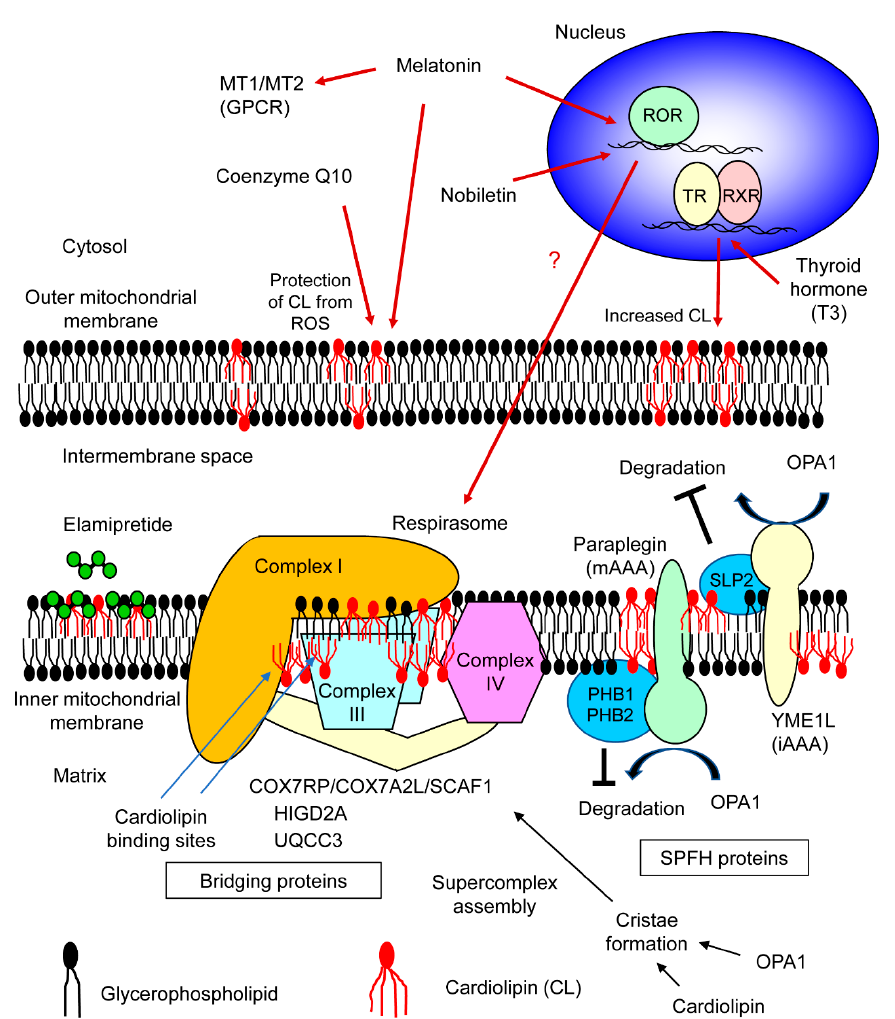
Figure 1. Molecules involved in mitochondrial respiratory chain supercomplex assembly. The respiratory chain supercomplex assembly factors and molecules affecting supercomplex formation which are reported to function in mitochondria of vertebrates are shown. Cardiolipin (CL), a phospholipid with four acyl chains, directly binds respiratory chain complexes on the cardiolipin binding sites in each complex. Cardiolipin may indirectly support mitochondrial respiratory chain supercomplex formation by maintaining cristae structure. COX7RP (cytochrome c oxidase subunit 7a-related polypeptide; also known as COX7A2L/SCAF1), HIGD2A (HIG1 hypoxia inducible domain family, member 2A), and UQCC3 (ubiquinol-cytochrome c reductase complex assembly factor 3) function as bridging proteins by direct binding with each respiratory chain complex. PHB1 (prohibitin 1), PHB2 (prohibitin 2), and SLP2 (stomatin-like protein 2) are SPFH (stomatin, prohibitin, flotillin, and Hflk/C) proteins which inhibit activity of proteases, mAAA (a member of AAA (ATPase associated with diverse cellular activities) proteins with enzymatic sites in the matrix of mitochondria) and iAAA (a member of AAA proteins with enzymatic sites in the intermembrane space of mitochondria), causing degradation of OPA1 (optic atrophy 1) responsible for the maintenance of cristae structure. Five bioactive small molecules are also shown. Coenzyme Q10 and melatonin are antioxidants that protect cardiolipin from reactive oxygen species (ROS). Functions of melatonin are also mediated by its G-protein coupled receptors (MT1 and MT2) or by nuclear receptor ROR (retinoid acid receptor-related orphan receptor). Nobiletin also activates ROR. T3 type of thyroid hormone binds to thyroid hormone receptor (TR). TR forms heterodimer with retinoid X receptor (RXR). T3 increases the amount of cardiolipin. Elamipretide is a synthetic tetrapeptide which modulates electrostatics of the mitochondrial inner